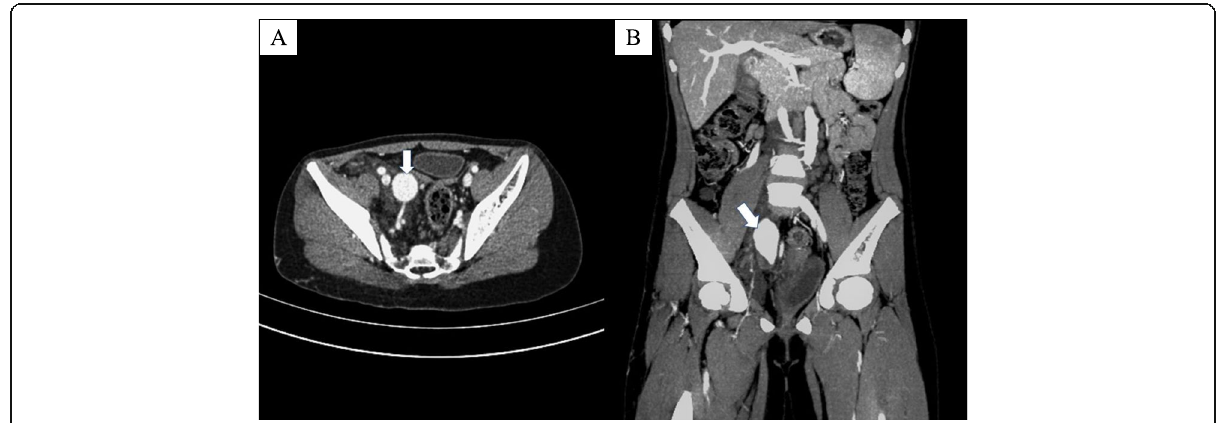
Fig. 4 Axial ( a ) and coronal ( b ) enhanced CT of abdomen and pelvis in the arterial phase demonstrate a fusiform aneurysm (arrow) of the proximal right internal iliac artery